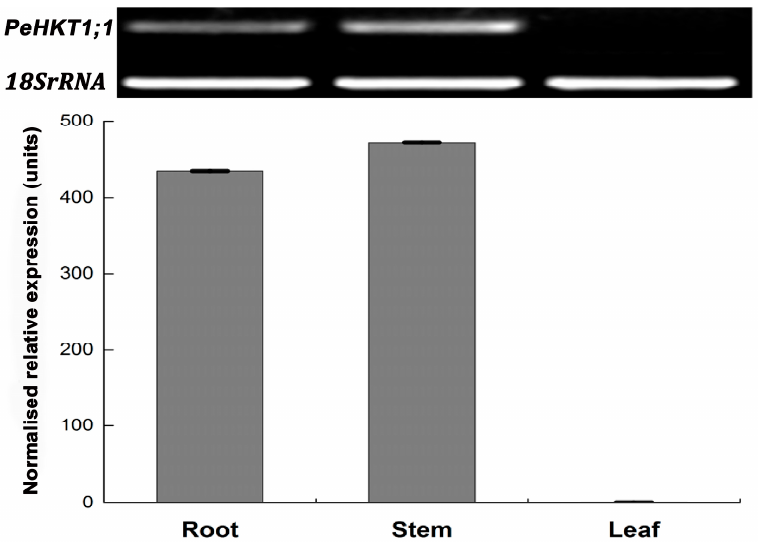
Figure 2. Tissue-specific expression levels of PeHKT1;1 analyzed by SqRT-PCR and qRT-PCR in “Nanlin895” poplar. The Y-axis represents relative quantitation and X-axis represents different tissues. The 18SrRNA gene was used as an internal control for SqRT-PCR, the EF1 α gene was used as a control for qRT-PCR, and the relative transcript levels were calculated using the 2 − ∆∆ C t method. Error bars showed standard deviations of three biological replicates.